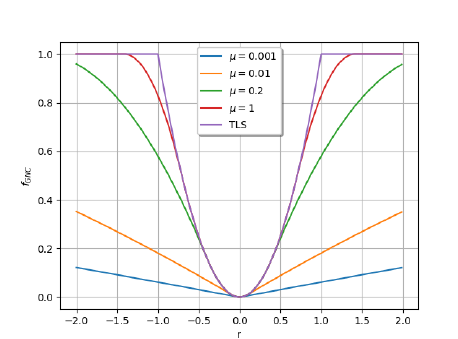
Figure 1: The surrogate cost function ρ µ ( r ) for GNC- TLS for different values of the control param- eter µ